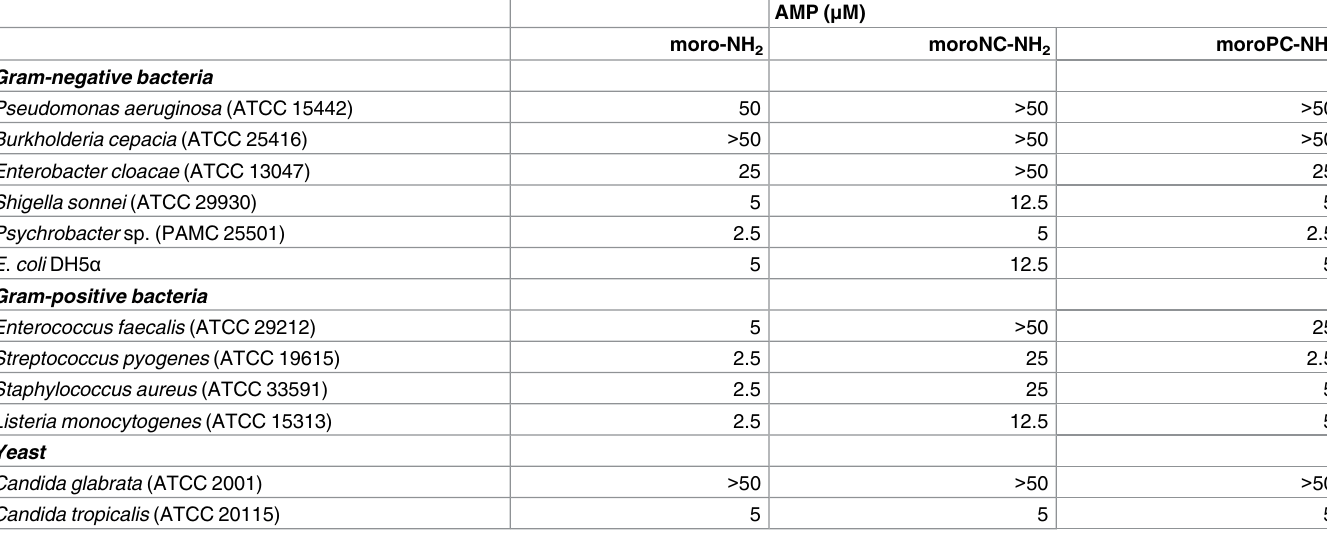
Table 3. Antimicrobial spectrum of synthetic, amidated moronecidin-like peptides from Antarctic fishes.